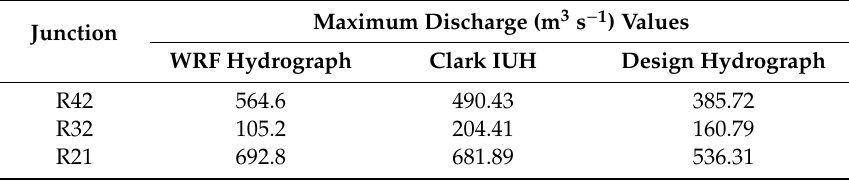
Table 3. Maximum discharge (m 3 s − 1 ) values of all the examined flood hydrographs used as input to the hydraulic–hydrodynamic model at junctions R42, R32, and R21.